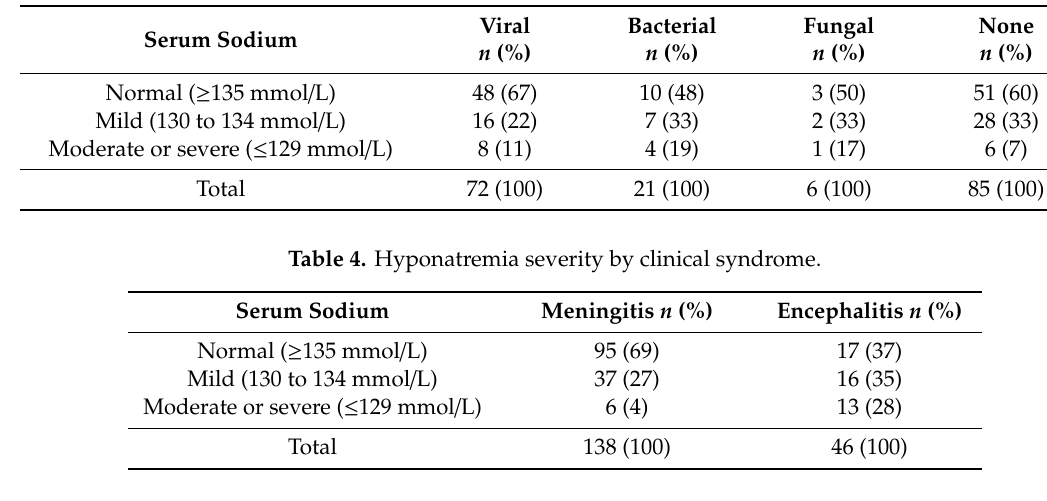
Table 3. Hyponatremia severity by organism category.